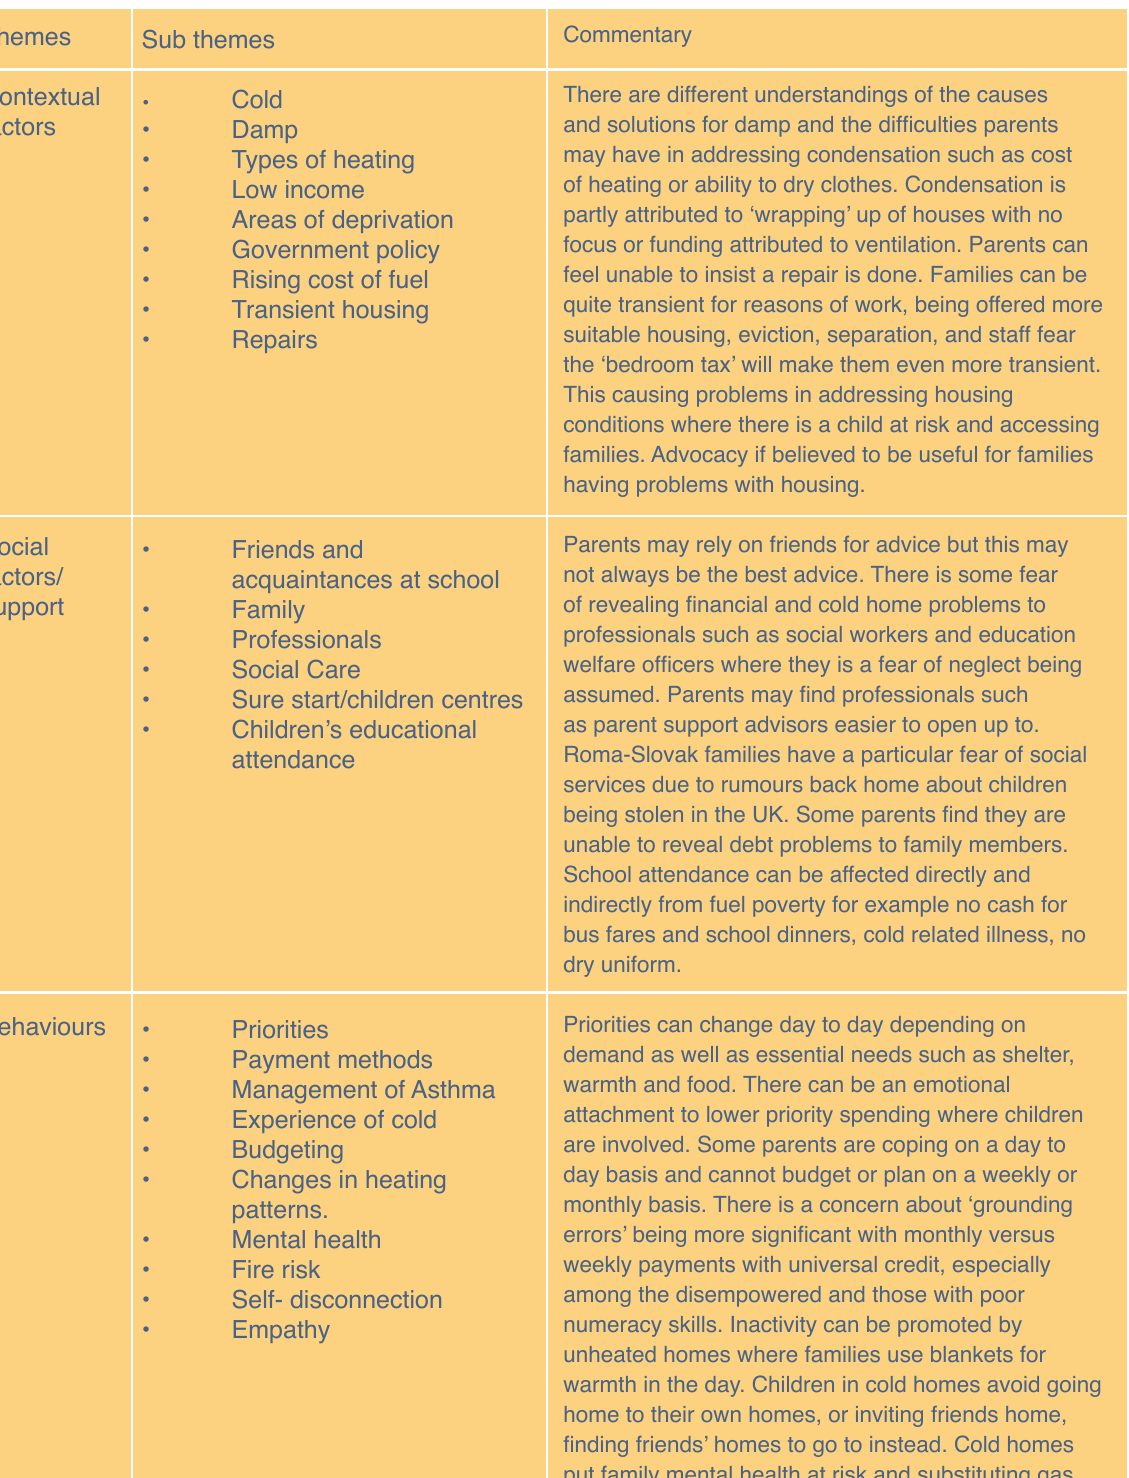
Table 8: Findings from Staff